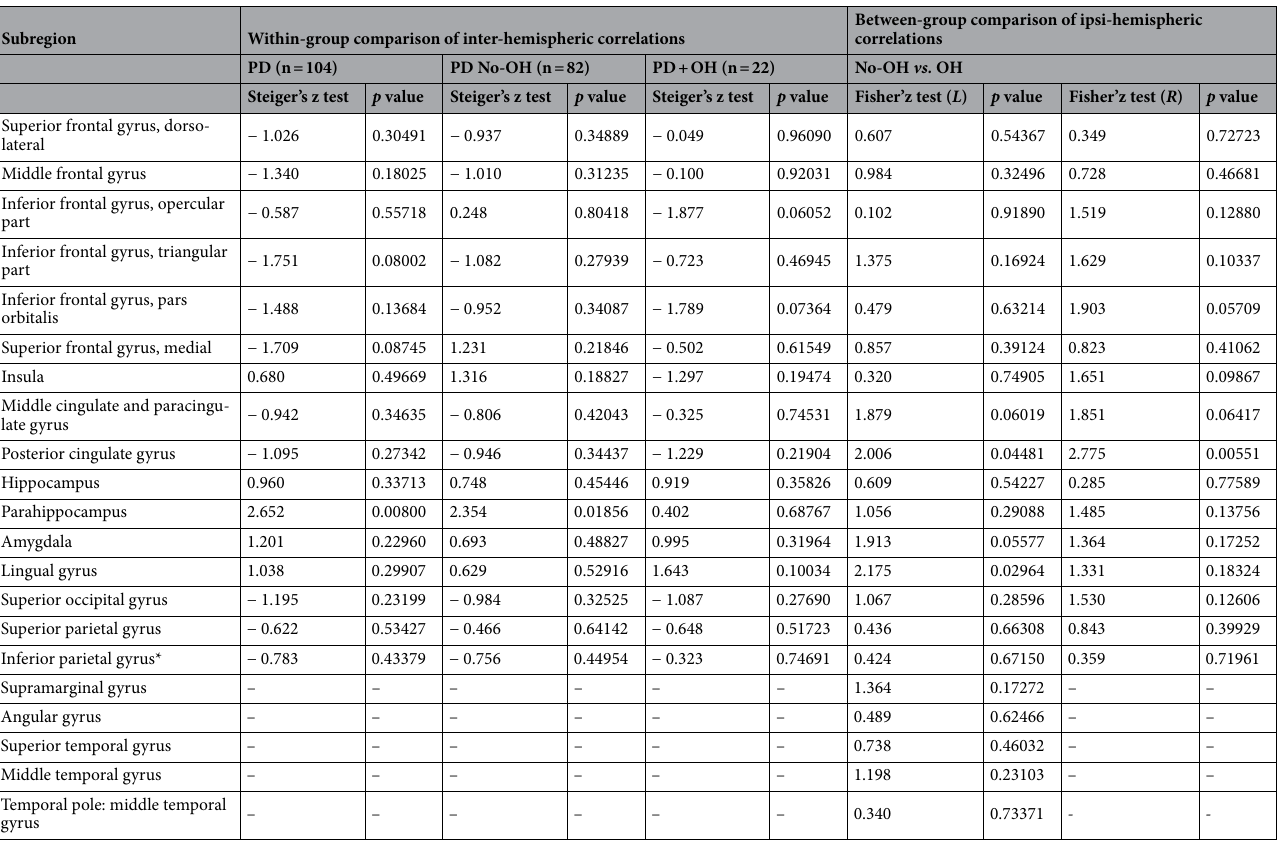
Table 3. Intra/interhemispheric regional differences of Spearman partial correlation coefficients. Steiger’z test was performed to compare two dependent correlations between topology-matched subregions of each hemisphere within a group, i.e., the associations of left caudate and left dorsolateral superior frontal gyrus (left hemisphere) compared to the associations of right caudate and right dorsolateral superior frontal gyrus (right hemisphere) within the same groups. Calculations were not performed in such instances where comparisons of corresponding subregions were not feasible as the language domain, e.g., the relation between left caudate and left supramarginal gyrus did not have an equivalent relation between right caudate and right supramarginal gyrus. Fisher’z test was utilized to evaluate the between-group difference between two independent correlations from corresponding hemisphere of No-OH vs. OH. For example, the association of left caudate and left dorsolateral superior frontal gyrus (left hemisphere) from PD No-OH was compared to the association of left caudate and left dorsolateral superior frontal gyrus (left hemisphere) from PD OH, Fisher’z test ( L ). None survived multiple comparison adjustments. *Supramarginal and angular gyrus are